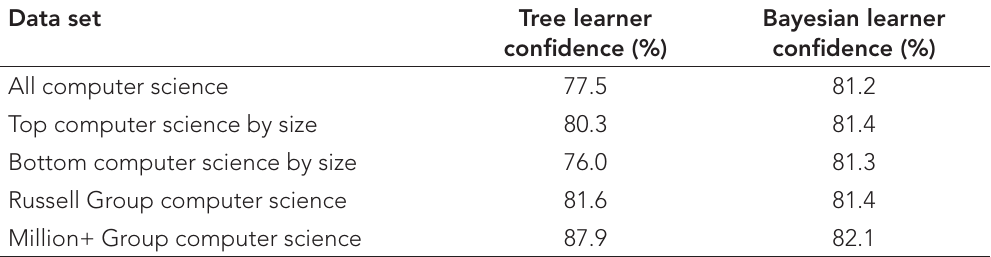
Bayesian learner confidence (%)